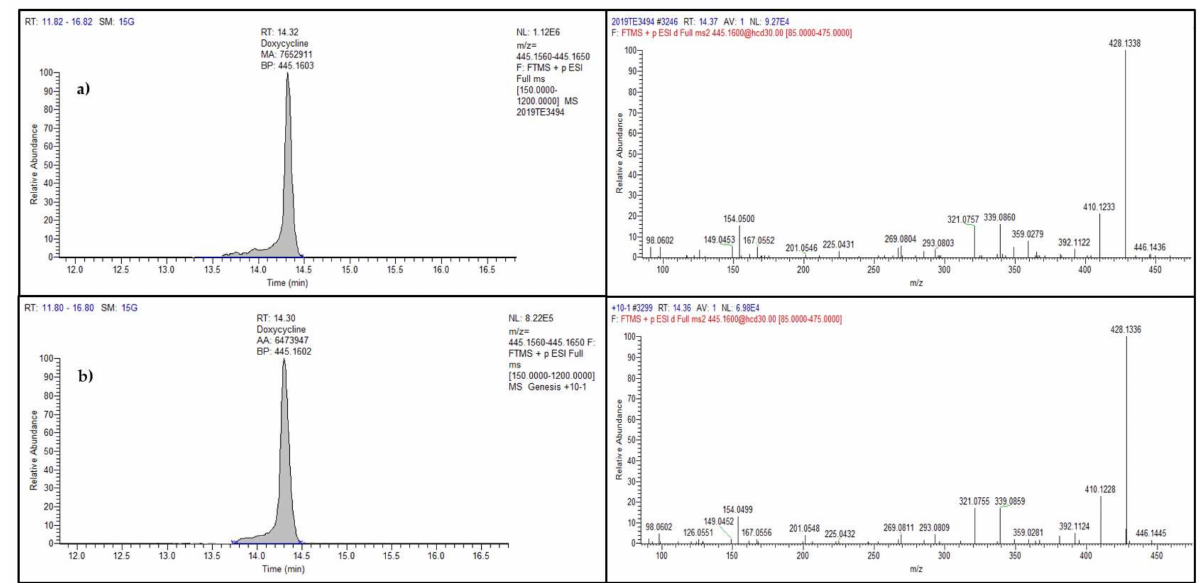
Figure 3. Chromatograms (left) and product ion spectra (right) of doxycycline in the real egg sample at 22 µ g kg − 1 ( a ) and in a spiked sample at 10 µ g kg − 1 ( b ).